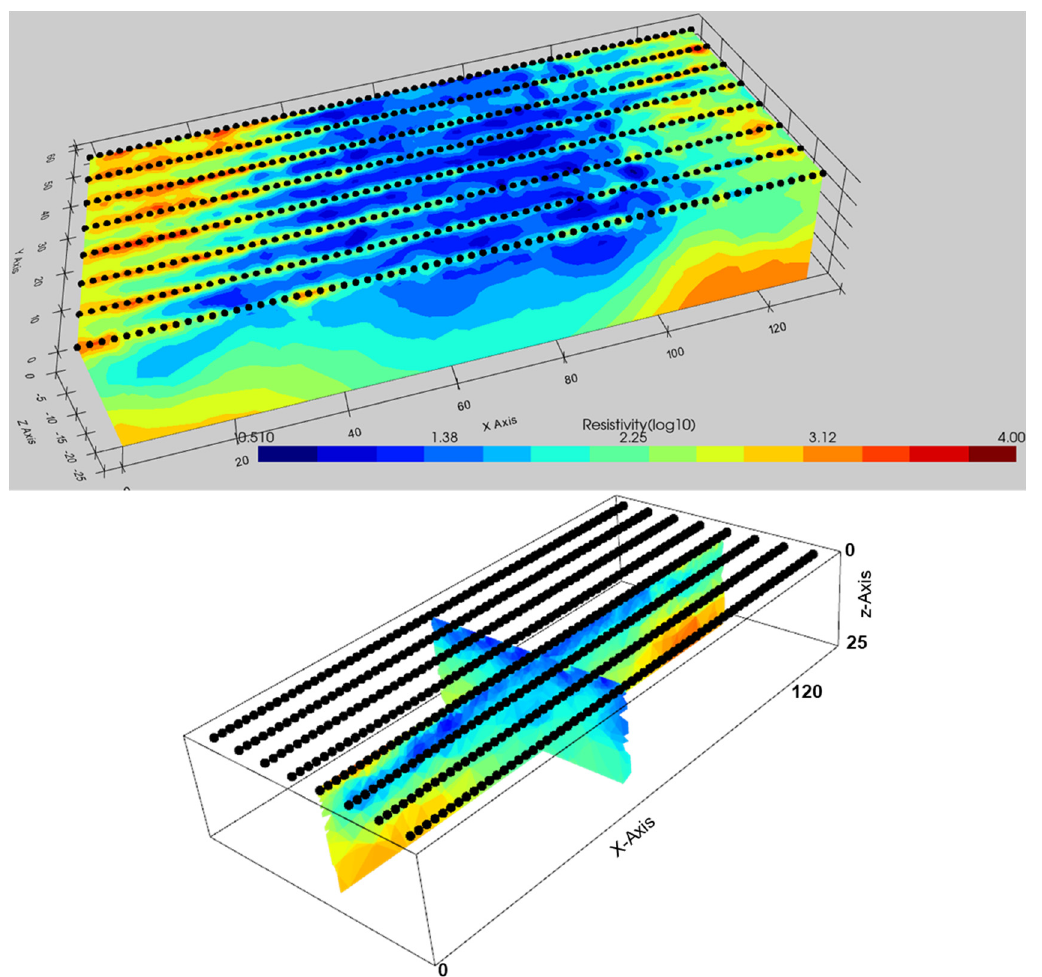
Figure 11. 3D resistivity model obtained by combining 2D measurements along profiles 1 to 8.